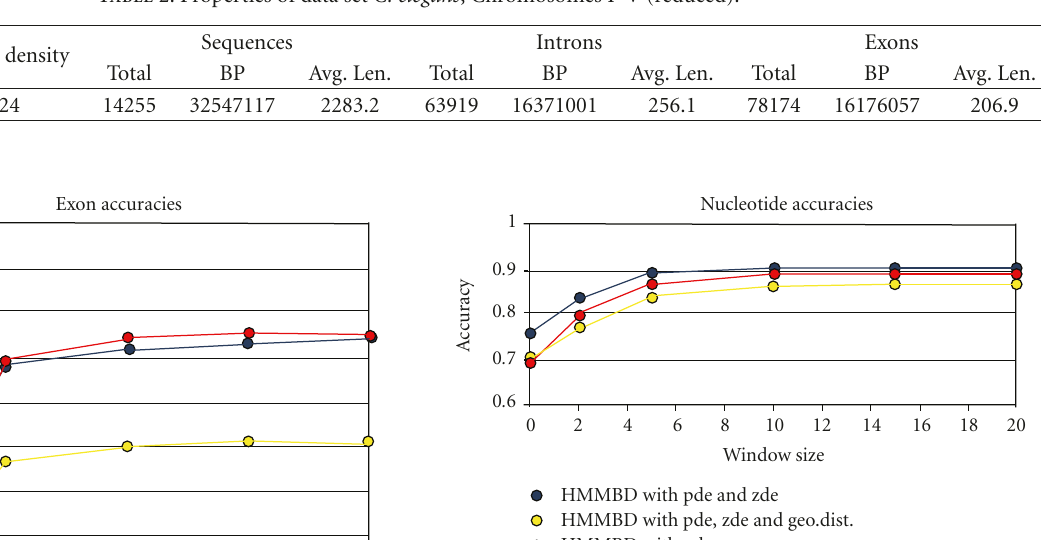
Table 2: Properties of data set C. elegans , Chromosomes I–V (reduced).